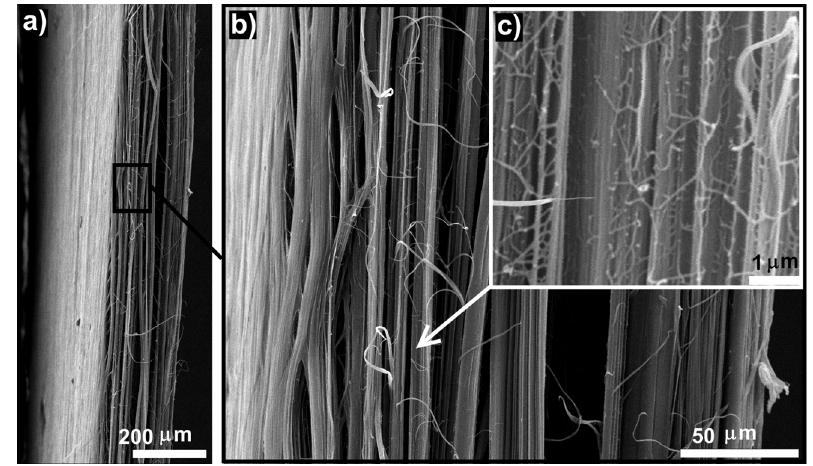
Figure 4. Typical fibrillar structure in the obtained bulk oriented films with different magnification. ( a ) 200 µ m; ( b ) 50 µ m; ( c ) 1 µ m. The film’s axis is in the vertical direction.